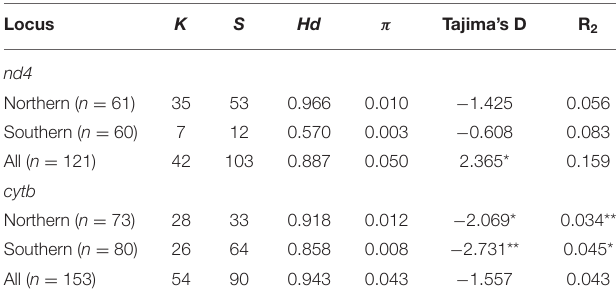
TABLE 3 | Genetic diversity and test statistics for selective neutrality within major lineage of Aneides populations for the mitochondrial nd4 and cytb